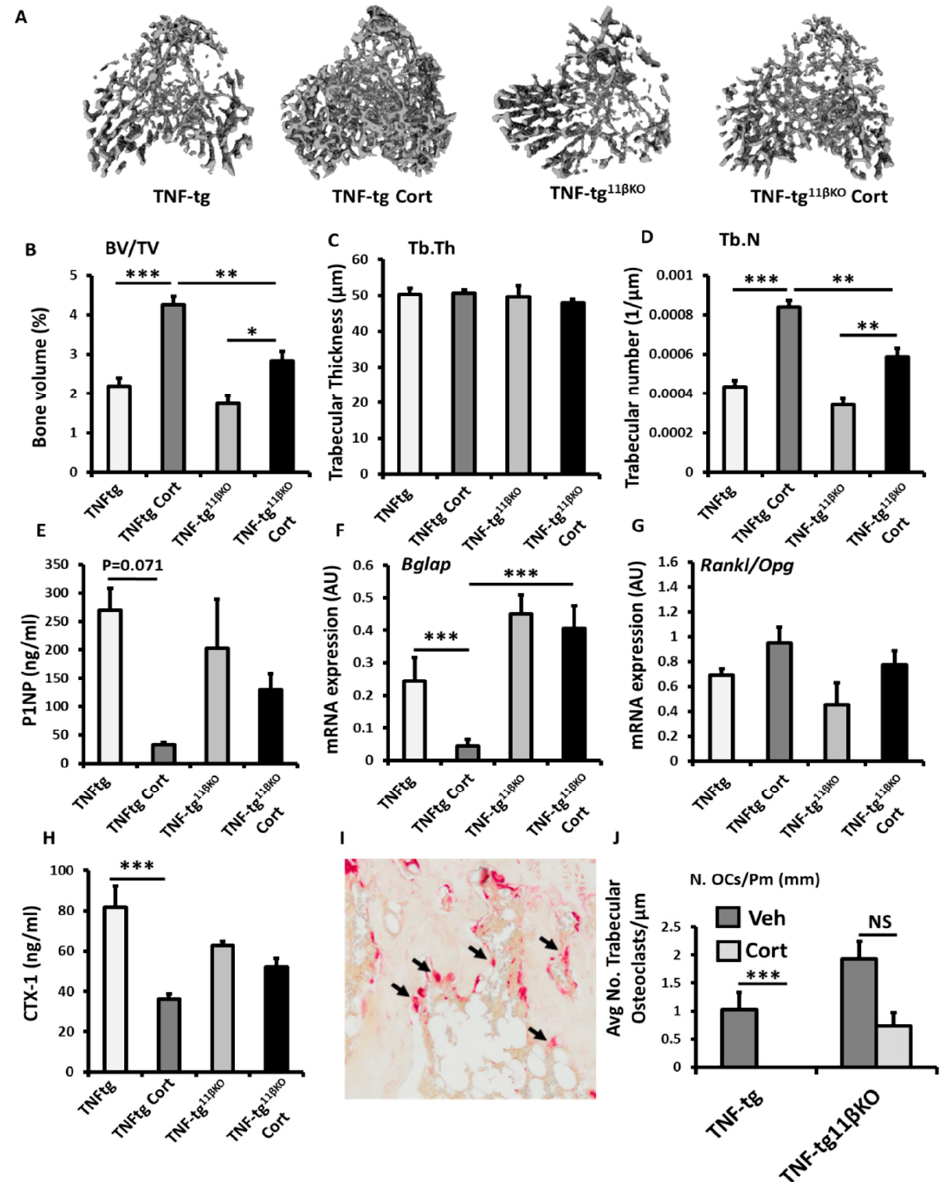
Figure 3. ( A ) Representative images of 3D reconstructions of tibia trabecular bone using micro-CT, ( B ) bone volume to tissue volume (BV/TV), ( C ) trabecular thickness (Tb.Th) and ( D ) trabecular number (Tb.N) determined by Meshlab software analysis of micro CT in TNF-tg and TNF-tg 11 β KO animals receiving either vehicle (Veh) or corticosterone (Cort) (100 µ g/mL) in drinking water over 3 weeks. ( E ) Serum P1NP (ng/mL), mRNA expression (AU) of ( F ) Bglap mRNA expression (AU), ( G ) RankL/Opg mRNA ratio in trabecular bone and ( H ) serum CTX-1 (ng/mL) in TNF-tg and TNF-tg 11 β KO animals receiving either vehicle or corticosterone (100 µ g/mL) in drinking water over 3 weeks and determined by ELISA and RT-qPCR. ( I ) Representative TRAP staining of trabecular osteoclasts on the corticoendosteal surfaces proximal of the epiphyseal growth plate in formalin fixed 5 µ m sections, and ( J ) average number of osteoclasts normalised to trabecular bone perimeter (N. OCs/Pm (mm)) in TNF-tg and TNF-tg 11 β KO animals receiving either vehicle or corticosterone (100 µ g/mL) in drinking water over 3 weeks determined using Image J analysis software following TRAP staining. Values are expressed as mean ± standard error of six animals per group. Statistical significance was determined using two-way ANOVA with a Tukey post hoc analysis. * p < 0.05, ** p < 0.005 and *** p <